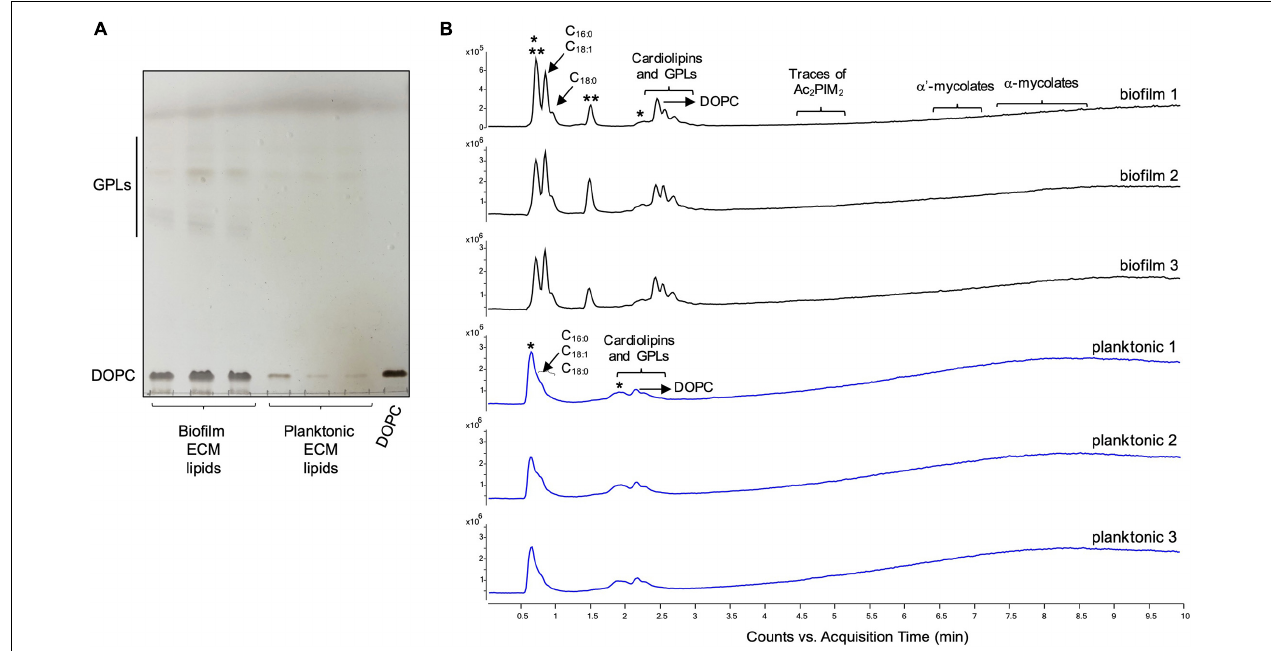
FIGURE 3 | Lipid composition of the ECM from planktonically grown and biofilm-grown Mabs NJH12. (A) Thin-layer chromatography analysis of ECM lipid fractions prepared from Mabs NJH12 extracellular matrices. 1/30 th of the total lipids prepared from 150 mL cultures of day 2 planktonically grown cells (corresponding to 1.95 ± 0.02 mg of dry bacilli devoid of ECM) and 150 mL cultures of day 5 biofilm-grown cells (corresponding to 1.11 ± 0.03 mg of dry bacilli devoid of ECM) was loaded and the plate was developed in chloroform:methanol:water (20:4:0.5 by vol.). Lipids were revealed by spraying with cupric sulfate (10% CuSO 4 in 8% phosphoric acid solution) and charring. The lipid fractions from triplicate cultures are shown. Pure DOPC control (250 ng) was loaded in the last lane. (B) Negative mode LC/MS analysis of the lipid fractions prepared from triplicate ECM preparations of biofilm-grown (black lines) (day 5) and planktonically grown (blue lines) (day 2) Mabs NJH12. Total ion chromatograms are shown. See Table 3 for the individual molecular species identified, their corresponding mass accuracy (ppm) values, and relative abundance in the planktonic and biofilm ECM samples. Single and double asterisks denote unknown, co-eluting, compounds. Peaks marked by double asterisks (**) were specifically seen in the ECMs prepared from biofilm cultures. Ac 2 PIM 2 , tetraacylated phosphatidylinositol dimannosides; DOPC, dioleoyl phosphatidylcholine (from SCFM); GPL,